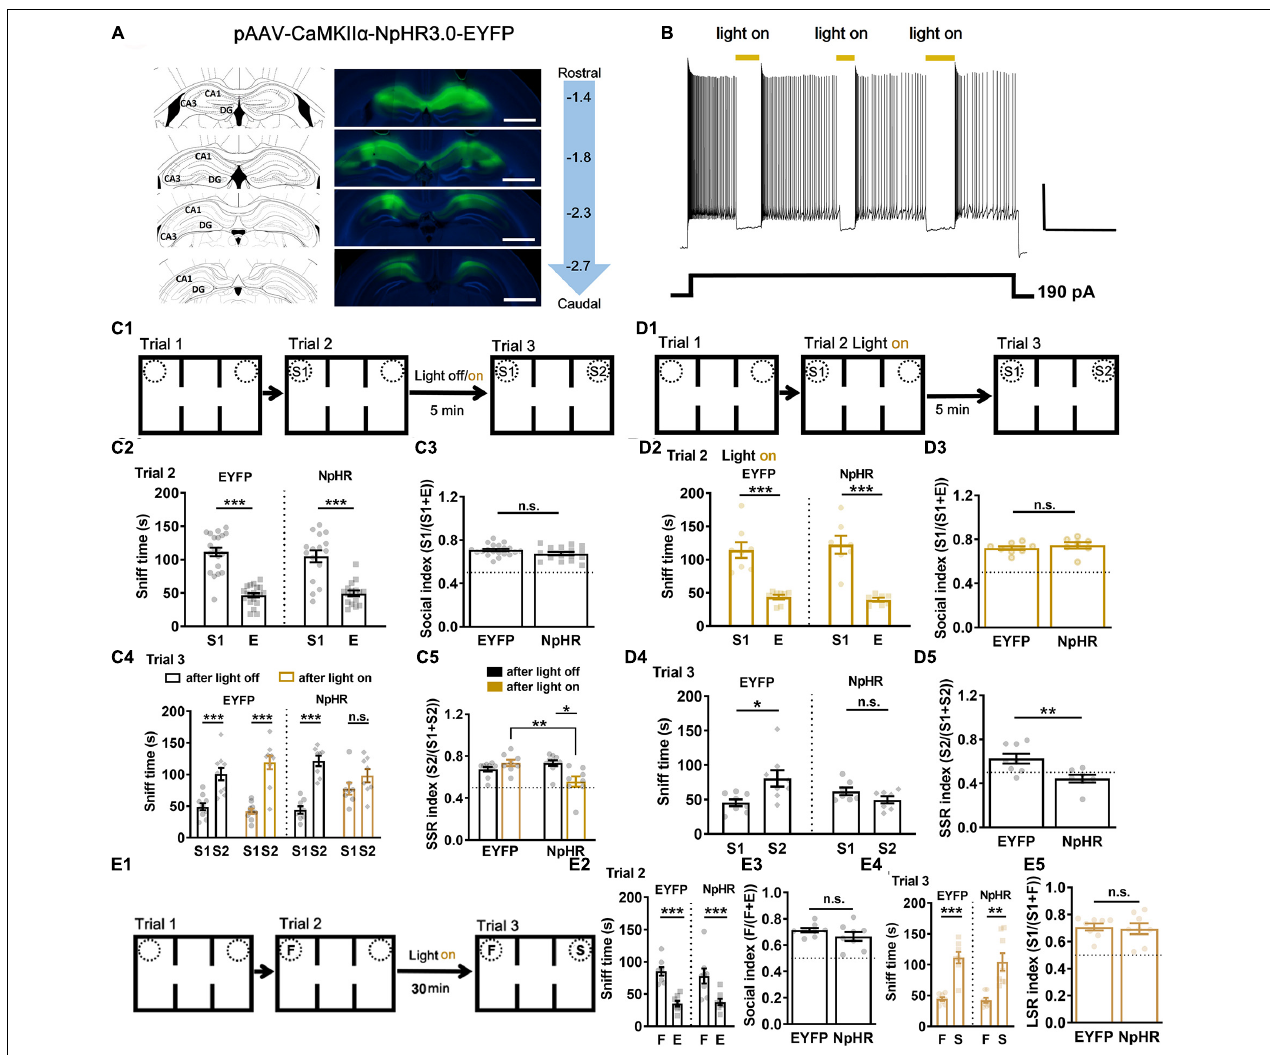
FIGURE 2 | Short-term but not long-term social memory-guided recognition disrupted by optogenetic silencing of CA1 neuronal activity. (A) Expression of pAAV-CaMKII-NpHR3.0-EYFP and pAAV-CaMKII-EYFP was checked in CA1 regions of the dorsal hippocampus at 3 weeks after the virus injection. Left: injection site according to the mouse brain atlas. Right: viral expression in CA1 regions, and distance (in mm) from bregma on the sagittal suture. Calibration bars, 1 mm. (B) Action potentials elicited by current injection were inhibited by light on (yellow, 594 nm) in NpHR3.0 expressed CA1 neurons in vitro . Calibration bar, horizontal 10 s, vertical 20 mV. (C1) Schematic of experimental paradigm for SSR. Light was given during ITI 5 min. (C2) All the mice showed normal sociability in trial 2 by exploring S1 vs. E ( n = 20 for EYFP, t = 8.8717, P < 0.0001; n = 16 for NpHR, t = 5.56007, P < 0.0001). (C3) All groups showed normal sociability with regards to social index in trial 2 ( n = 20 for EYFP, n = 16 for NpHR, t = 1.696, P = 0.0990). (C4) Light on during the 5-min ITI impaired subsequent social recognition in trial 3 by exploring S1 vs. S2 in NpHR group but not in EYFP group, while light off had no significant effect on both the groups ( n = 10 for EYFP with light off, t = 4.56881, P = 0.000476; n = 10 for EYFP with light on, t = 6.69973, P < 0.0001; n = 8 for NpHR with light off, t = 7.6989, P < 0.0001; n = 8 for NpHR with light on, Wilcoxon test, P = 0.1953). (C5) NpHR with light on group showed lower SSR index in contrast to EYFP with light group or to NpHR with light off group ( n = 10 for EYFP, n = 8 for NpHR; P = 0.0027, χ 2 = 14.18. Dunn’s multiple comparisons test, EYFP on vs. NpHR on, P = 0.0036; NpHR off vs. NpHR on, P = 0.0245; *** P < 0.001). n.s., not significant. (D1) Schematic of experimental paradigm for SSR. Light was given during trial 2. (D2) All the mice showed normal sociability in trial 2 by exploring S1 vs. E ( n = 8 for EYFP, t = 5.7557, P < 0.0001; n = 7 for NpHR, t = 5.9880, P < 0.0001). (D3) Light on during trial 2 by exploring S1 vs. E had no significant effects on sociability in terms of social index ( n = 8 for EYFP, n = 7 for NpHR, t = 0.7935, P = 0.4417). (D4) Light on during trial 2 still impaired social recognition in trial 3 by exploring S1 vs. S2 in NpHR but not EYPF control ( n = 8 for EYFP, Wilcoxon test, P = 0.0391; n = 7 for NpHR, t = 1.6203, P = 0.1311; * P < 0.05). (D5) NpHR with light on group showed lower SSR index in contrast to EYFP with light group ( n = 8 for EYFP, n = 7 for NpHR, t = 3.076, P = 0.0089; ** P < 0.01). (E1) Schematic of experimental paradigm for LSR. (E2) All the mice showed normal sociability in trial 2 by exploring F vs. E ( n = 8 for EYFP, t = 4.7343, P = 0.000115; n = 8 for NpHR, t = 3.8325, P = 0.000657; *** P < 0.001). (E3) EYFP and NpHR groups showed similar sociability with regards to social index in trial 2 ( n = 8 for EYFP, n = 8 for NpHR, t = 1.269, P = 0.2252). (E4) Light on during the 30-min ITI did not affect social recognition in trial 3 by exploring F vs. S in NpHR group ( n = 8 for EYFP, t = 6.965, P = 0.000437; n = 8 for NpHR, t = 3.688, P = 0.007781; ** P < 0.01; *** P < 0.001). (E5) NpHR with light on group showed similar LSR index as EYFP group ( n = 8 for EYFP, n = 8 for NpHR, t = 0.2723, P = 0.7894). S1, a first stranger mouse; E, empty cage; S2, a second stranger mouse; F, a familiar littermate of the subject mice. Data presented as mean ± SEM. Statistical analysis was performed by using Wilcoxon test, Kruskal–Wallis test followed by Dunn’s post hoc analysis, student’s t test or two-way ANOVA followed by Sidak’s post hoc